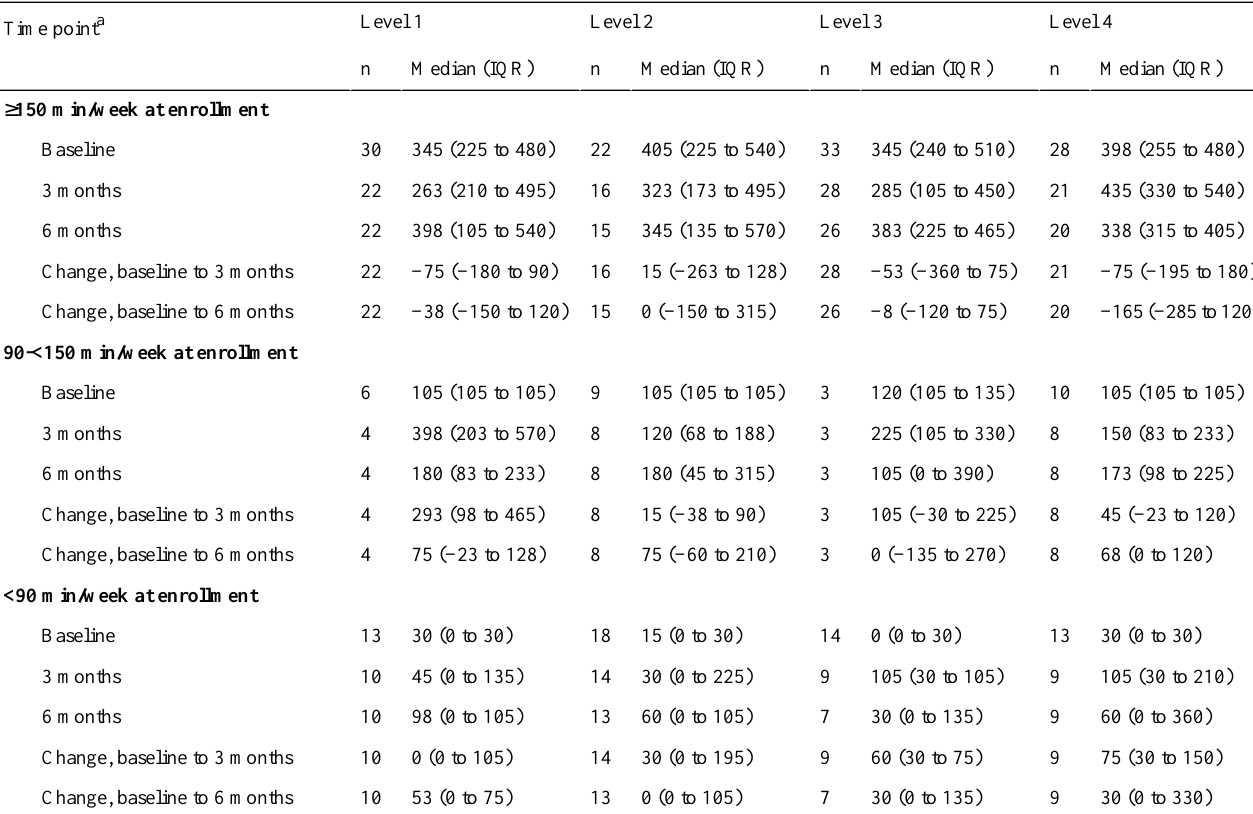
Table 3. Moderate-to-vigorous intensity aerobic physical activity minutes per week at baseline, 3 months, and 6 months among men with prostate cancer participating in a technology-supported behavioral intervention, overall and by level randomized and baseline